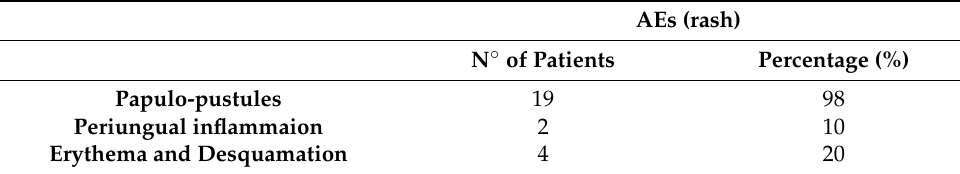
Table 1. Skin manifestations.